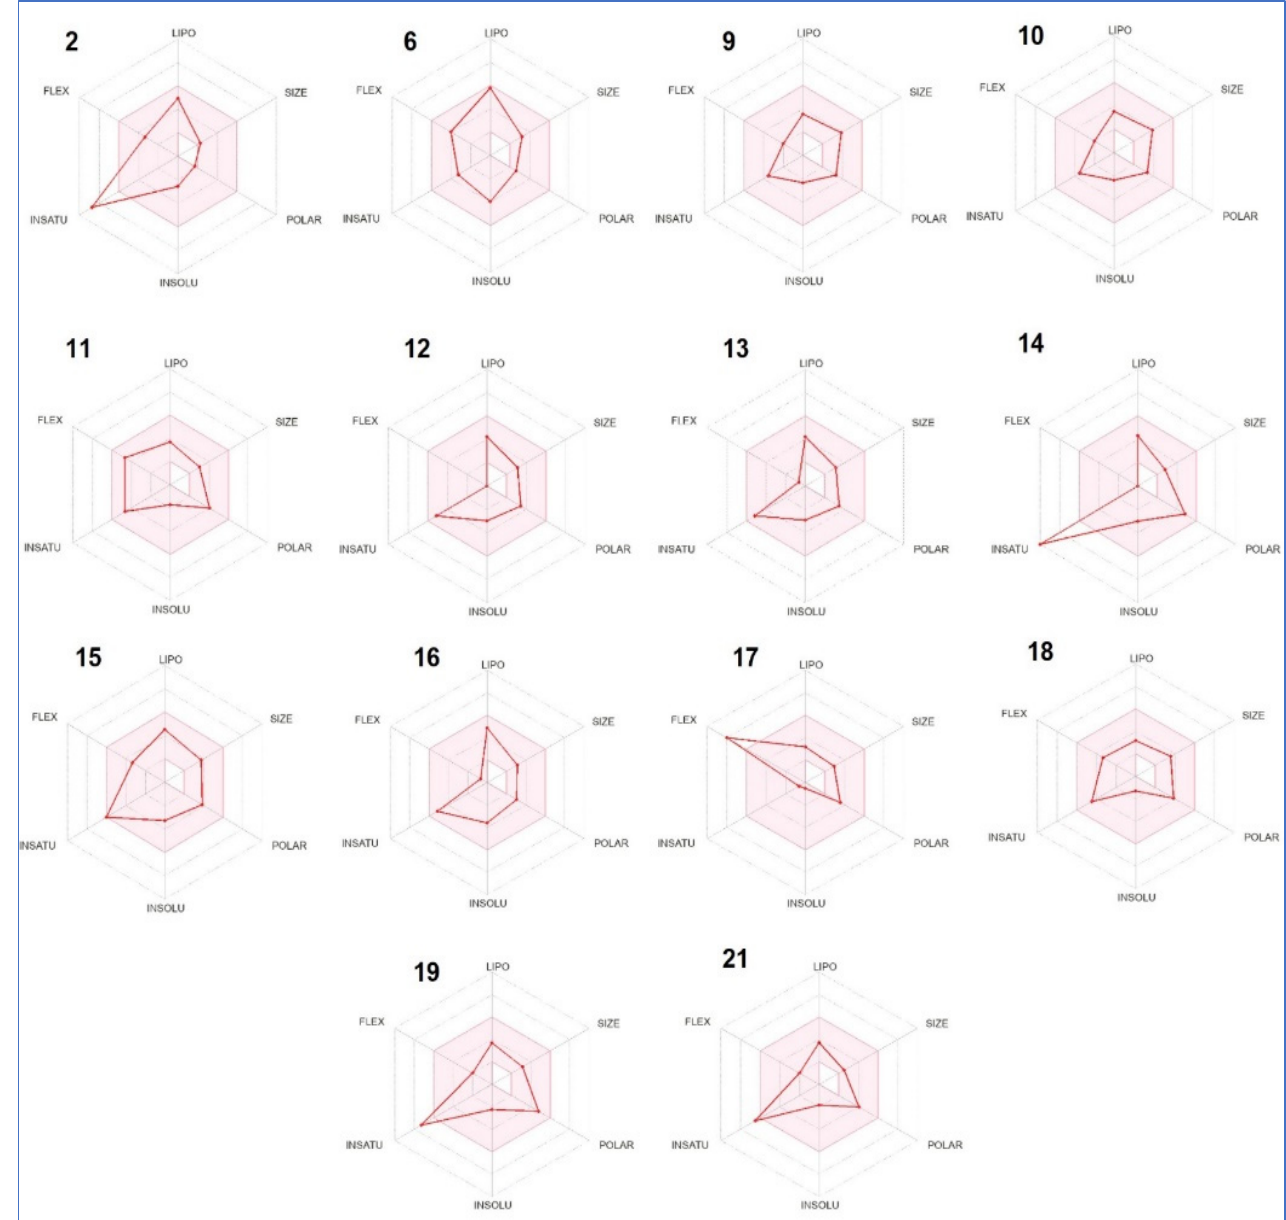
Figure 2. Radar plot of the selected peptides and phytoconstituents based on physicochemical indices ideal for oral bioavailability.